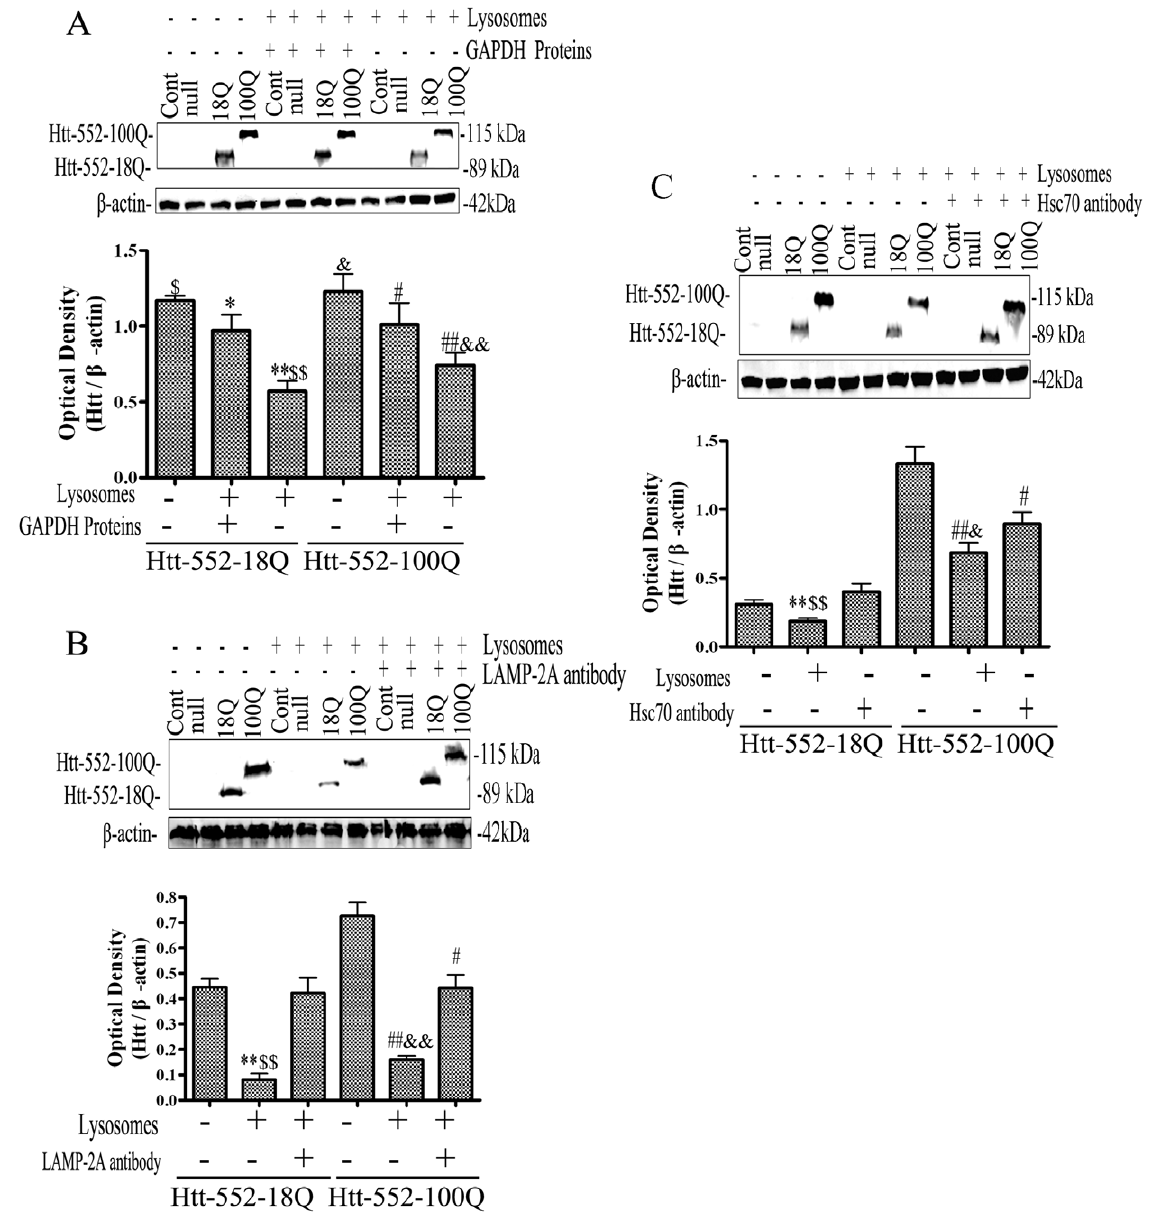
Figure 6. Inhibition of Htt-552 degradation by blocking CMA pathway. (A) The effects of GAPDH on degradation of Htt-552. The isolated lysosomes were incubated with 10 m g GAPDH and Htt-552 for 30 min at 37 u C. At the end of the incubation, lysosomes were collected by centrifugation and the levels Htt-552 were determined with immunoblotting. Values are the mean 6 SE of three experiments. **P , 0.01, *P , 0.05 (compared with Htt-552-18Q without lysosomes); ## P , 0.01, # P , 0.05 (compared with Htt-552-100Q without lysosomes); $$ P , 0.01 (compared with Htt-552-18Q without GAPDH); && P , 0.01 (compared with Htt-552-100Q without GAPDH). (B) The effects of LAMP-2A neutralizing antibody on degradation of Htt-552 by isolated lysosomes. The incubation of lysosomal preparation with Htt-552 was described as above. Values are the mean 6 SE of three independent experiments **P , 0.01 (compared with Htt-552-18Q without lysosomes); # P , 0.05, ## P , 0.01 (compared with Htt- 552-100Q without lysosomes); $$ P , 0.01 (compared with Htt-552-18Q without LAMP-2A antibody); && P , 0.01 (compared with Htt-552-100Q without LAMP-2A antibody). (C) The incubation of lysosomal preparation with Htt-552 was described as above. The effects of Hsc70 neutralizing antibody on degradation of Htt-552 by isolated lysosomes. Values are the mean 6 SE of three independent experiments. **P , 0.01 (compared with Htt-552-18Q without lysosomes); ## P , 0.01, # P , 0.05 (compared with Htt- 552-100Q without lysosomes); $$ P , 0.01 (compared with Htt-552-18Q without Hsc70 antibody); & P , 0.05 (compared with Htt-552-100Q without Hsc70 antibody).